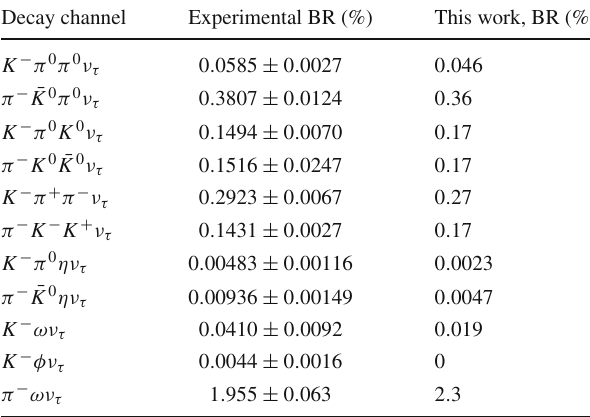
Table 10 Comparison with available experimental [57] branching ratios for three pseudoscalar decay modes (or pseudoscalar plus ω or φ ) Decay channel Experimental BR (%) This work, BR